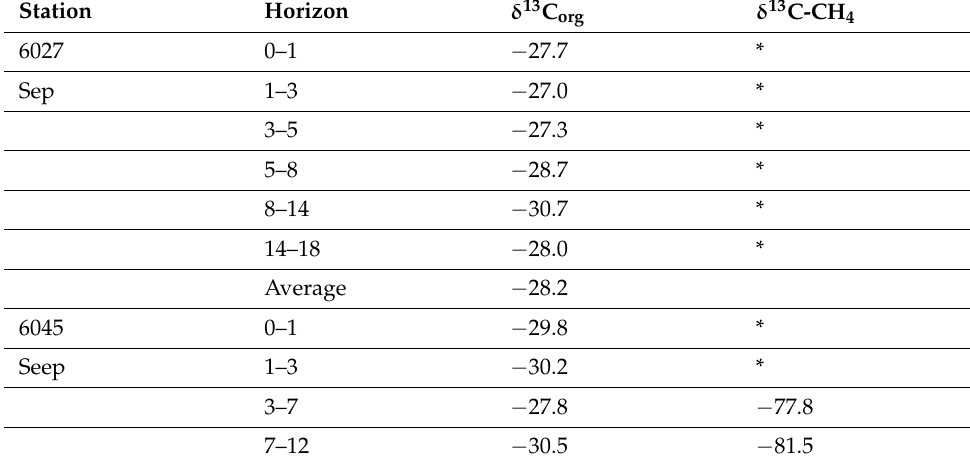
Figure 10. Rates of methane oxidation (MO, nmol dm − 3 day − 1 ) in the Laptev Sea shelf sediments. Methane carbon oxidation to CO 2 and assimilation into organic matter of microbial biomass and dissolved organic carbon (BM + DOC). Table 3. Carbon isotopic composition of organic matter ( δ 13 C org ) and methane carbon ( δ 13 C-CH 4 ) in the sediments of three Laptev Sea